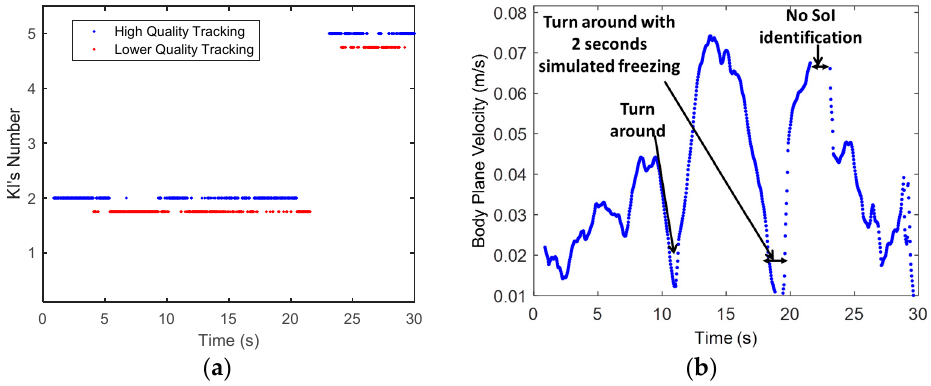
Figure 9. The SoI’s gait experiment results. ( a ) Shows the SoI’s Quality of tracking (KSs’ 2 and 5), and ( b ) Shows the SoI’s Body plane (x-y) velocity over time. It is seen that there are continuous burst periods (5–10, 12–13, 20–22), the skeleton is distorted from its reference KS, and hence the tracking quality is low. These bursts correspond to the artifacts shown in Figure 5 of shadowing, merge of skeletons, and going in and out of the Kinect range; ( b ) shows the SoI’s ground plane velocity. The nulls in the plane velocity, fits the tagging of turn arounds as was derived from the Kinect video color image at around 11, and 18–20 s.